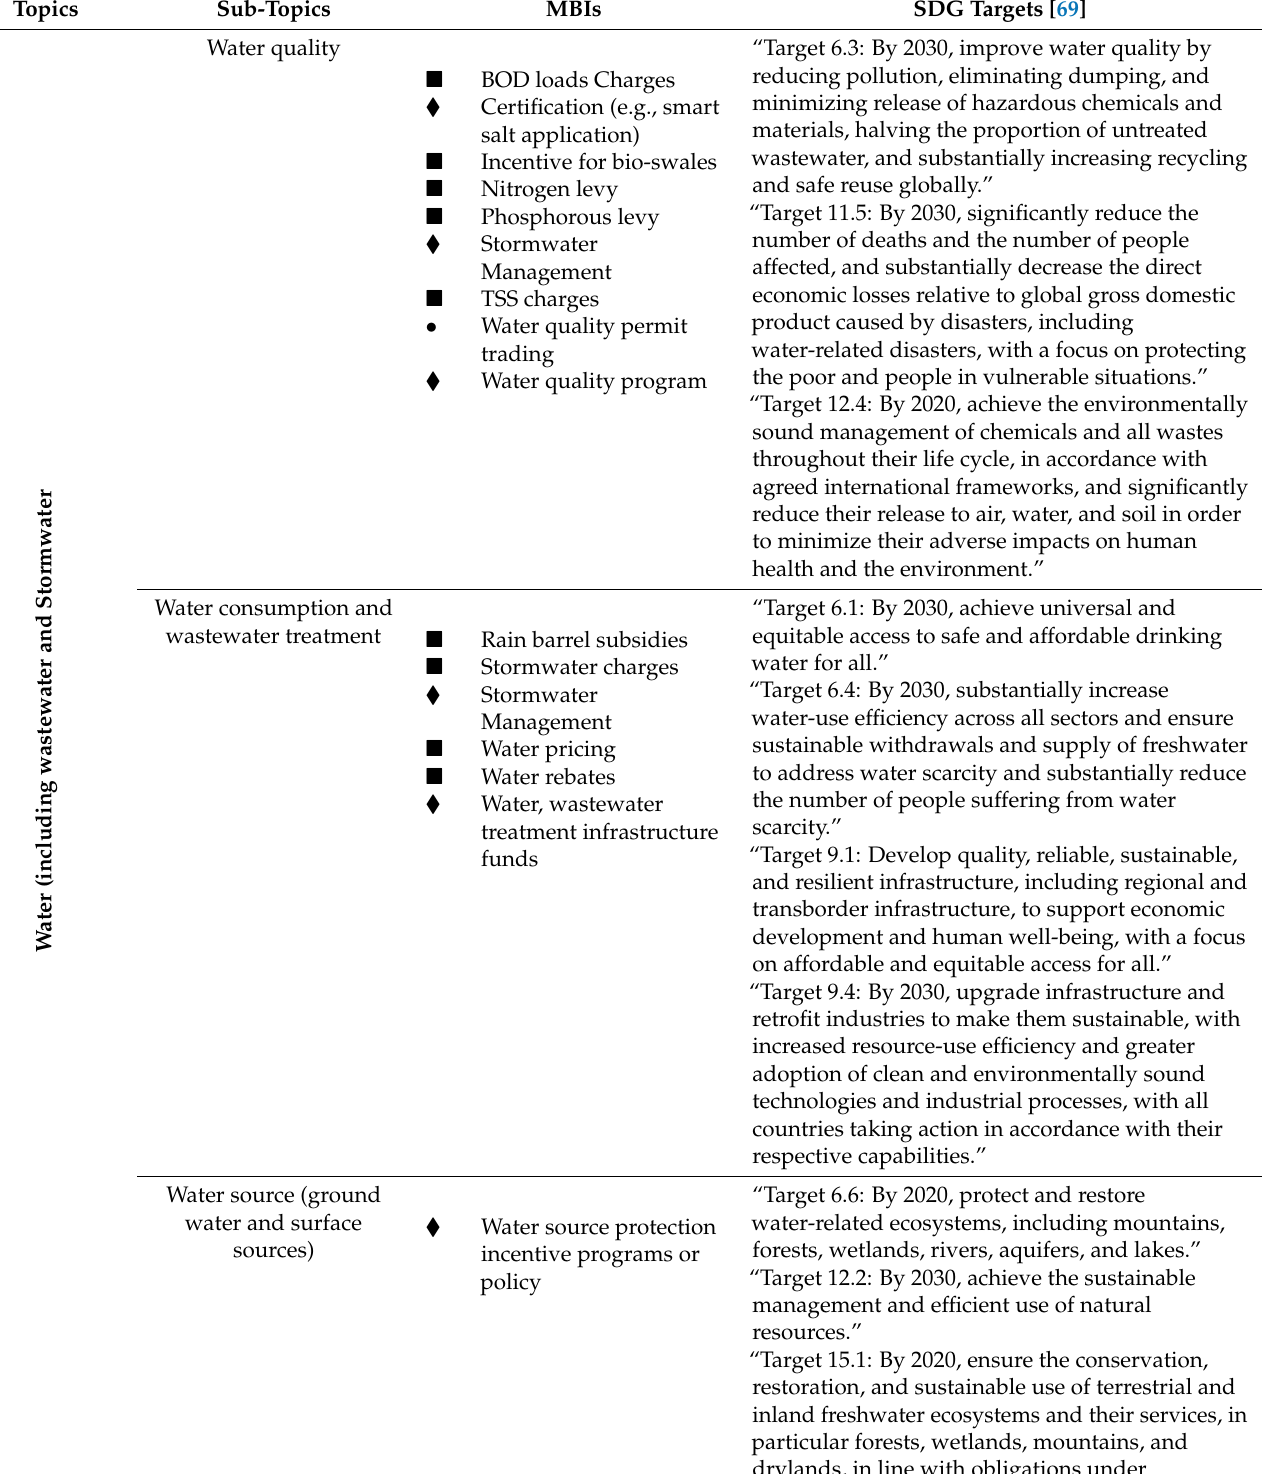
Table 4. Categorization of MBIs for Water and Related SDG